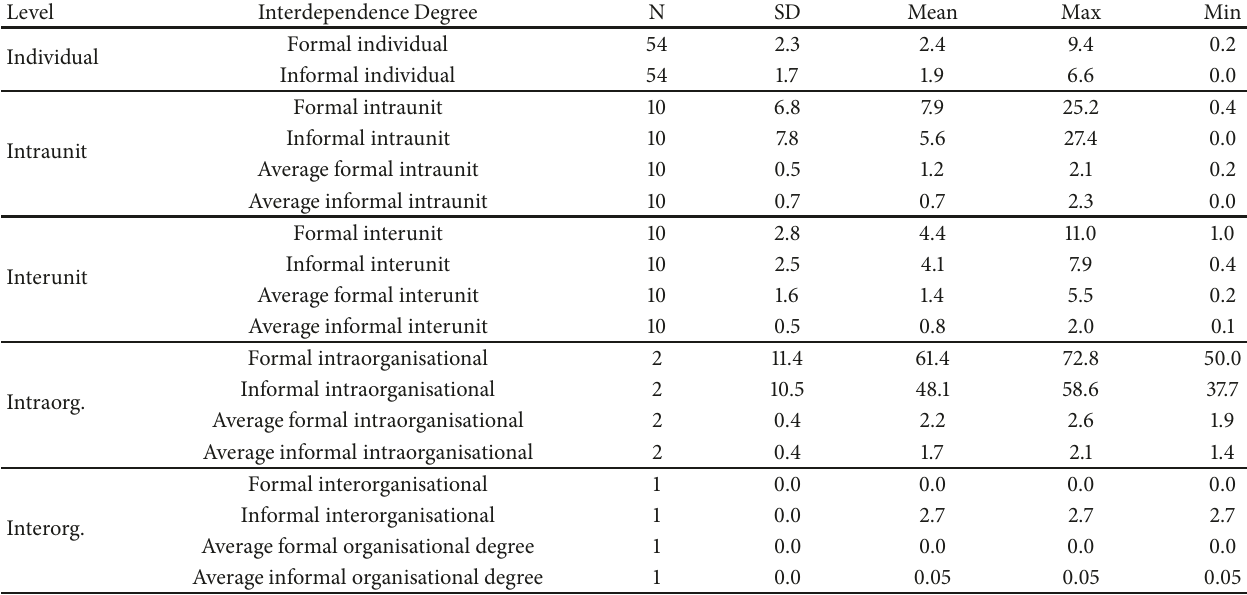
Table 10: Summary of interdependence degrees values at multiple levels.